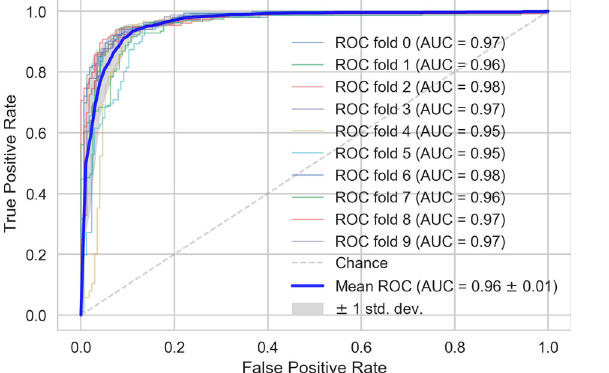
Figure 9. Ranking of ACC scores after model optimization.